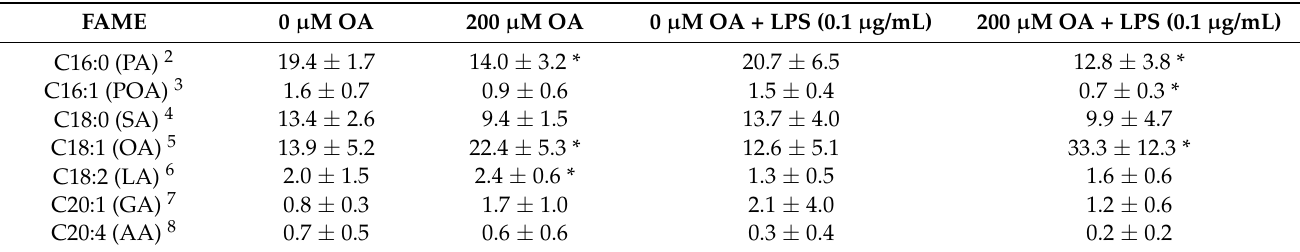
Table 2. Fatty acid composition (% of total FAME 1 as means ± S.D) of phospholipids of murine RAW264.7 macrophages after incubation with 200 µ M OA compared to LPS-treated control cells.